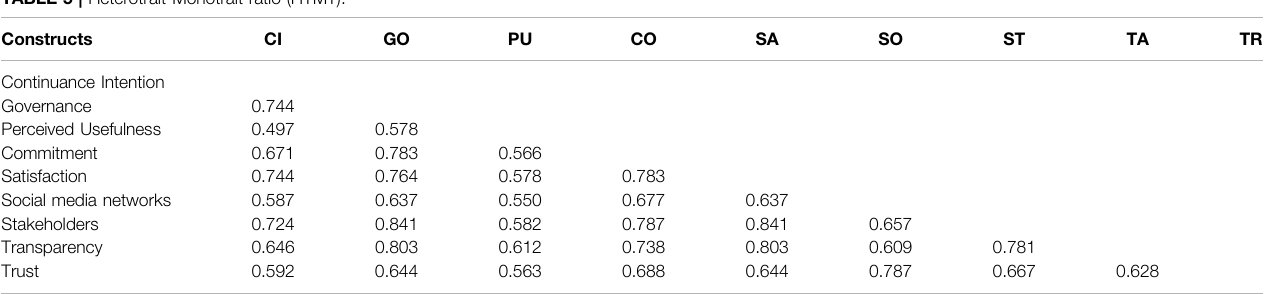
TABLE 5 | Heterotrait-Monotrait ratio (HTMT).